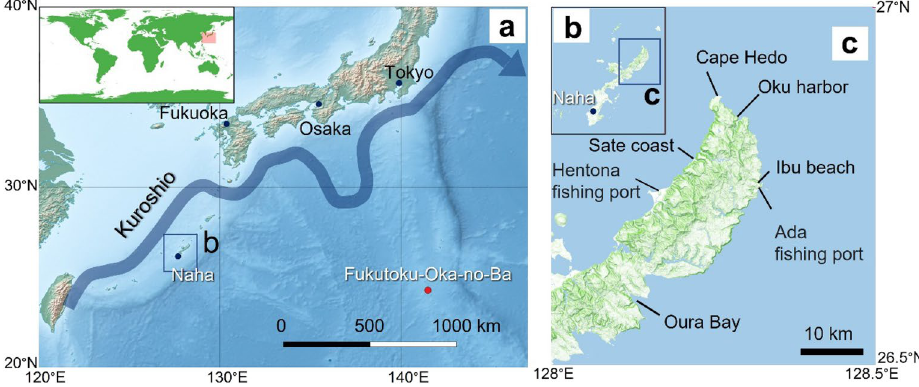
Figure 1. Locations of the eruption site, the island of Okinawa where the pumice drifted, and the observation sites. ( a ) Location of Fukutoku-Oka-no-Ba submarine volcano (red circle) and the Ryukyu Islands, Japan. ( b ) Okinawa Island is ~ 1300 km from the eruption site. ( c ) Sampling sites of drifted pumice along the coast of northern part of Okinawa Island (Kunigami Village) are shown in panel. The flow path of the Kuroshio Current shown in Panel ais based on Quick Bulletin of Ocean Conditions of Japan Coast Guard 12 . Panel is made with Natural Earth (https:// www. natur alear thdata. com). Topographic maps of panels b and c are based on GSI Vector Tile Experiment (https:// maps. gsi. go. jp/ vector/) by the Geospatial Information Authority of